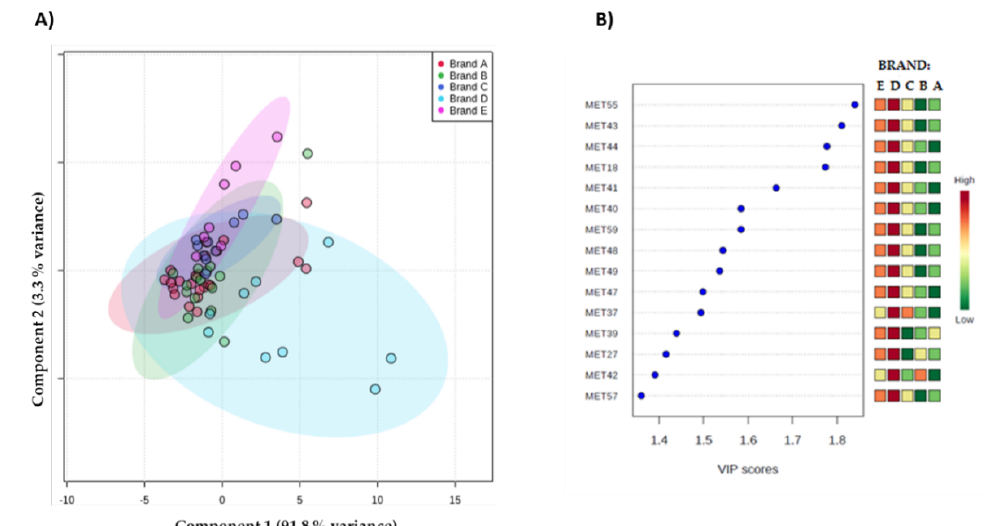
Figure 3. Partial least squares discriminant analysis (PLS-DA) results for volatile profiles in EC brewed by capsules from 5 commercial Italian brands.; ( A ) 2D SCORE PLOT for Component 1 and Component 2. The ellipse represents the confidence around each of the brands; ( B ) VIP score of metabolites resulting from the PLS-DA loading plots with threshold > 1.